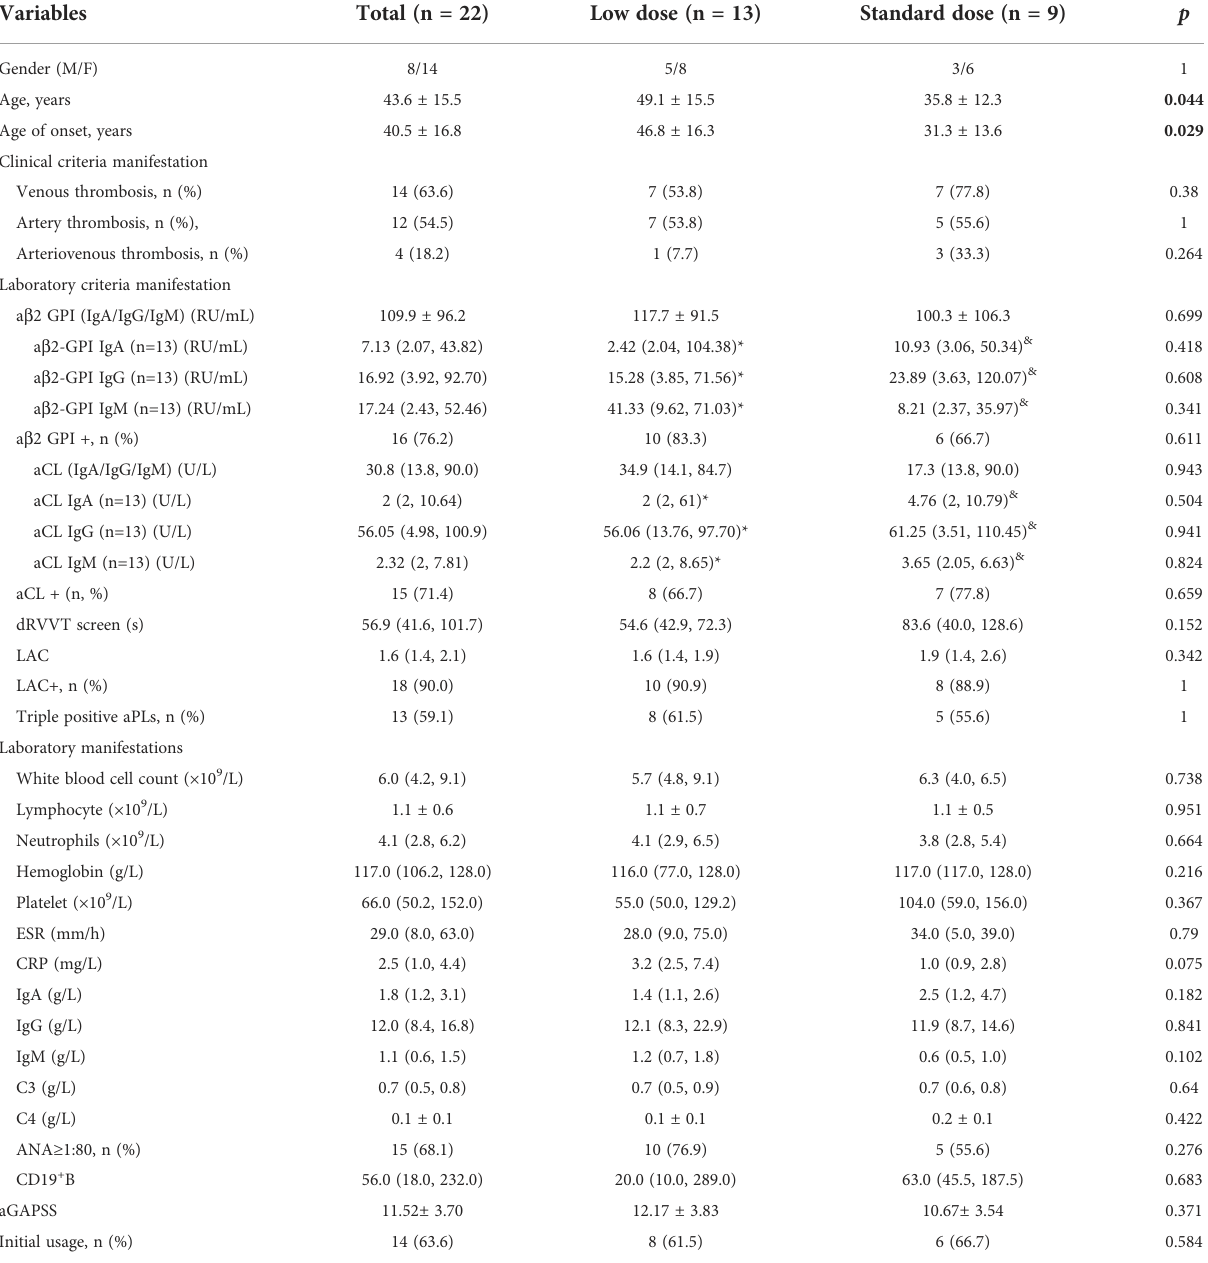
TABLE 2 Baseline characteristics of APS patients with LD-RTX versus